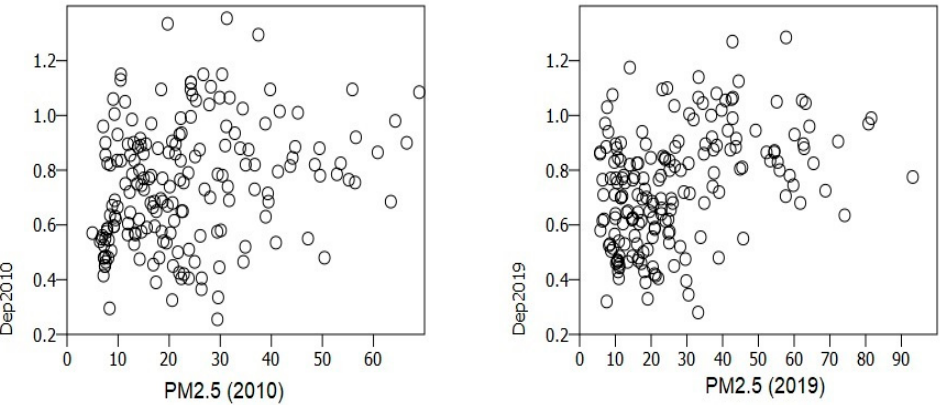
Figure 1. Scatter plots of the relationship between average annual PM 2.5 and the incidence of depression in 2010 and 2019.